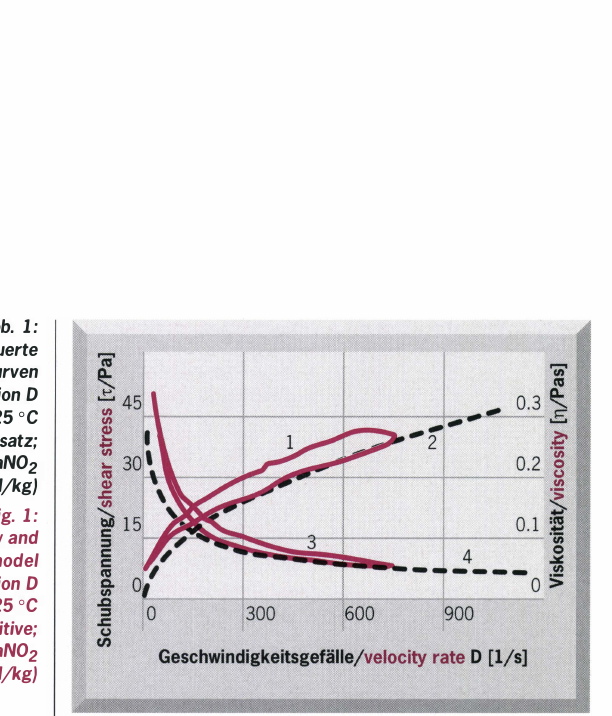
Fig. 1: Stress controlled flow and viscosity curves for model dispersion D c (sample 1} at 25 a 1; 3: without